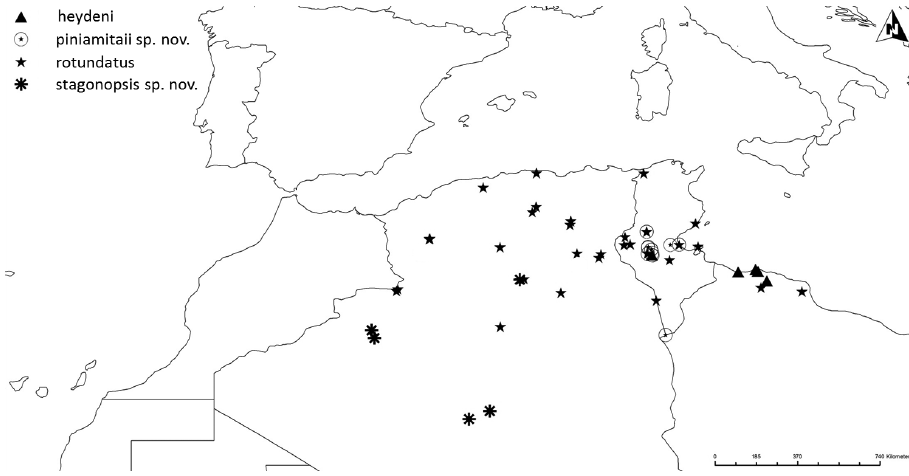
Figure 18. Distributional records of G. heydeni , G. piniamitaii sp. n., G. rotundatus, and G. stago- nopsis, sp.